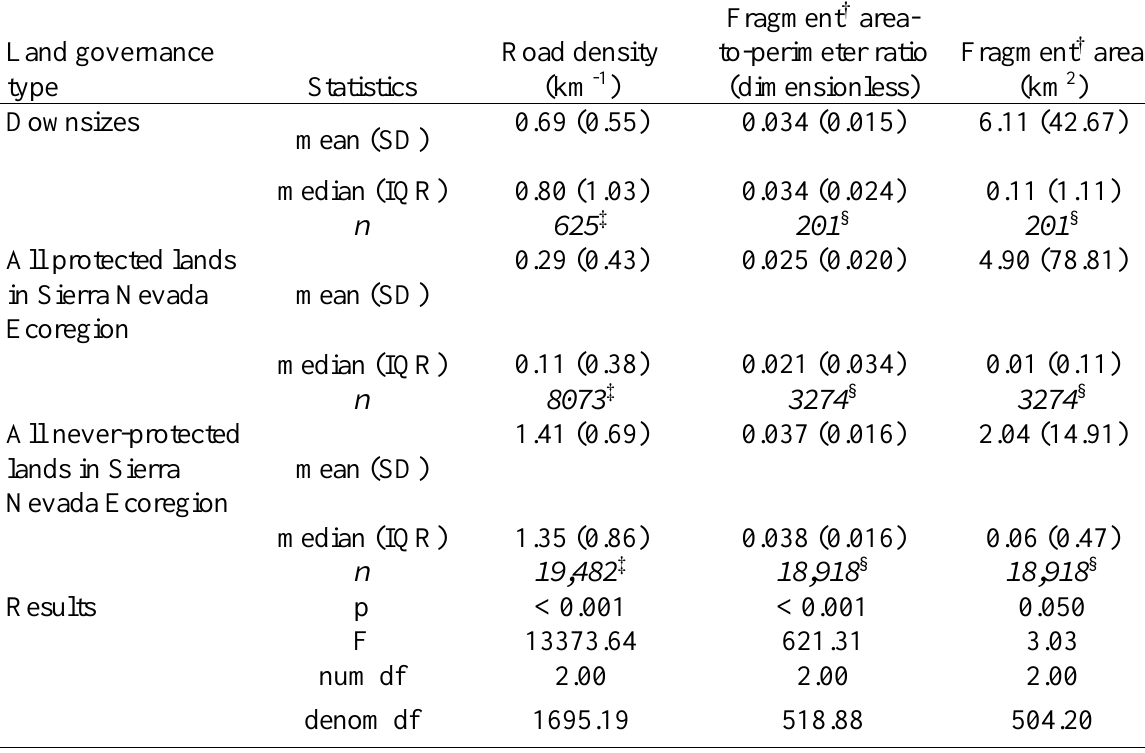
Table A1.14: Habitat fragmentation indicators at the Ecoregional scale for all land cover types; results of Welch’s ANOVA tests. See Table A1.15 for results of post-hoc